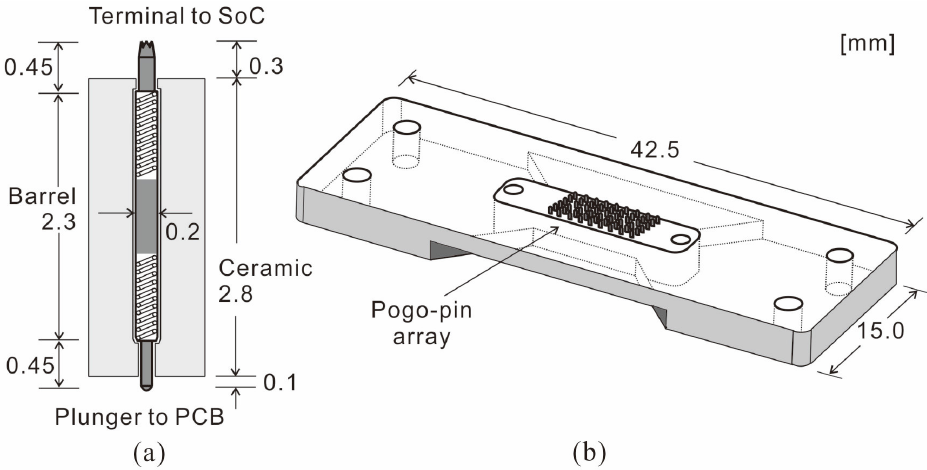
Figure 2. Sketches of ( a ) uncompressed Pogo-pin and ( b ) ceramic housing containing Pogo-pin